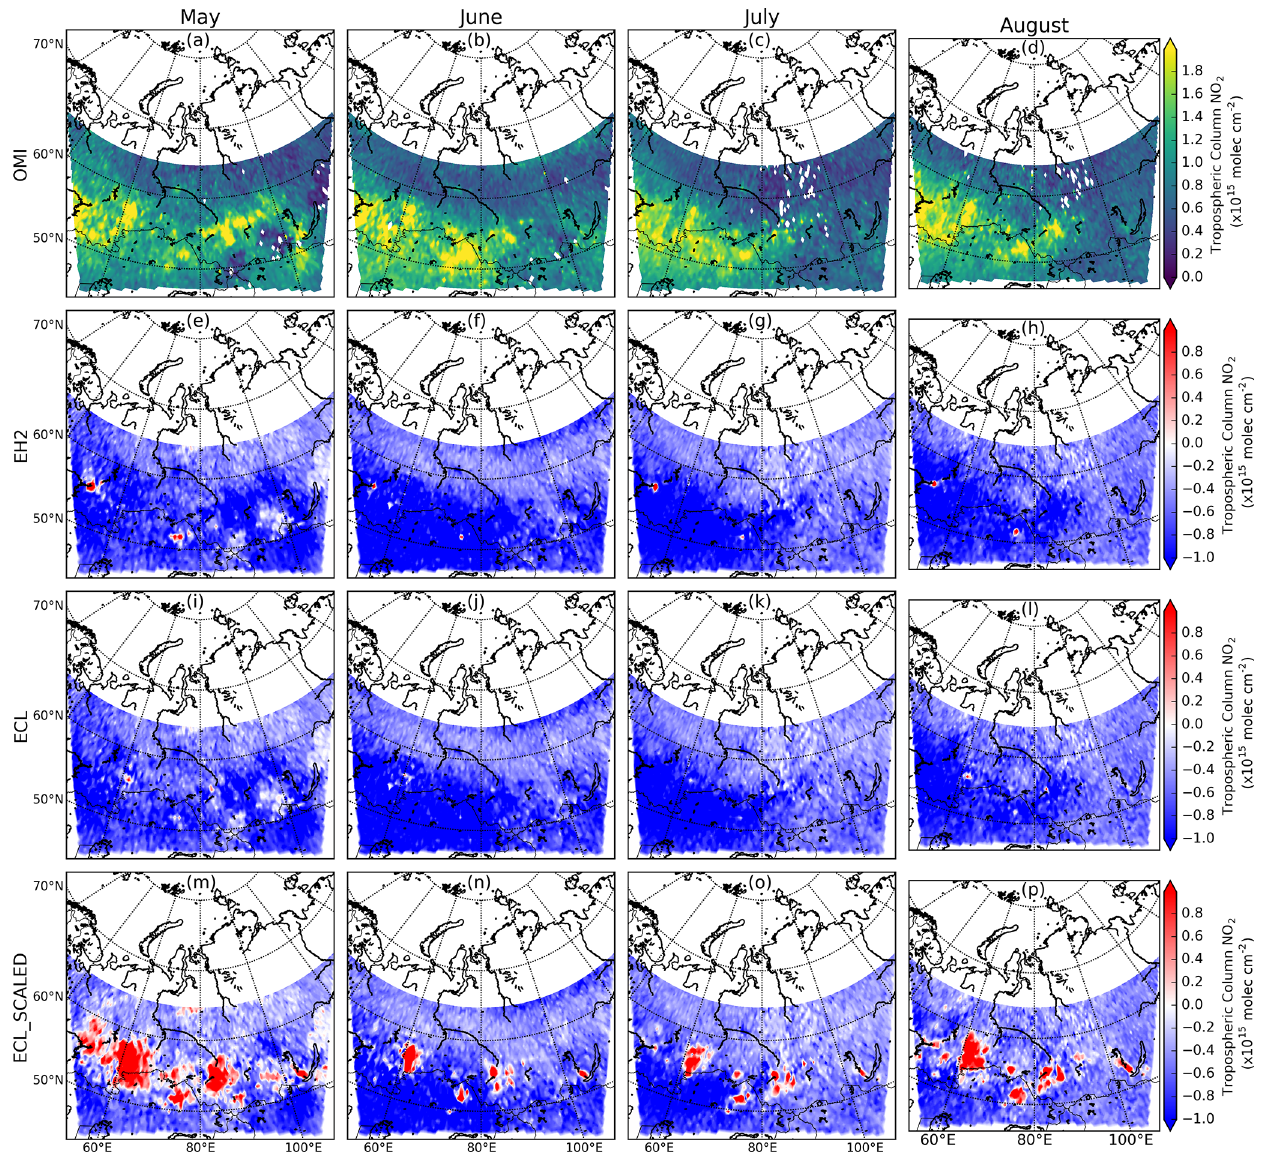
Figure 3. Observed and model-observed tropospheric column NO 2 . Panels (a) – (d) show mean OMI tropospheric column NO 2 for May– August. Panels (e) – (h) show WRF-Chem bias (model–satellite) using the EDGAR-HTAP v2.2 anthropogenic emission inventory for May– August. Panels (i) – (l) show WRF-Chem bias using the ECLIPSE v5a anthropogenic emission inventory for May–August. Panels (m) – (p) show WRF-Chem bias using the ECLIPSE v5a anthropogenic emission inventory for May–August, with the energy and transport sectors scaled by a factor of 2. Results not shown < 65 ◦ , due to satellite retrieval uncertainty increasing at high latitudes, associated with a large solar zenith